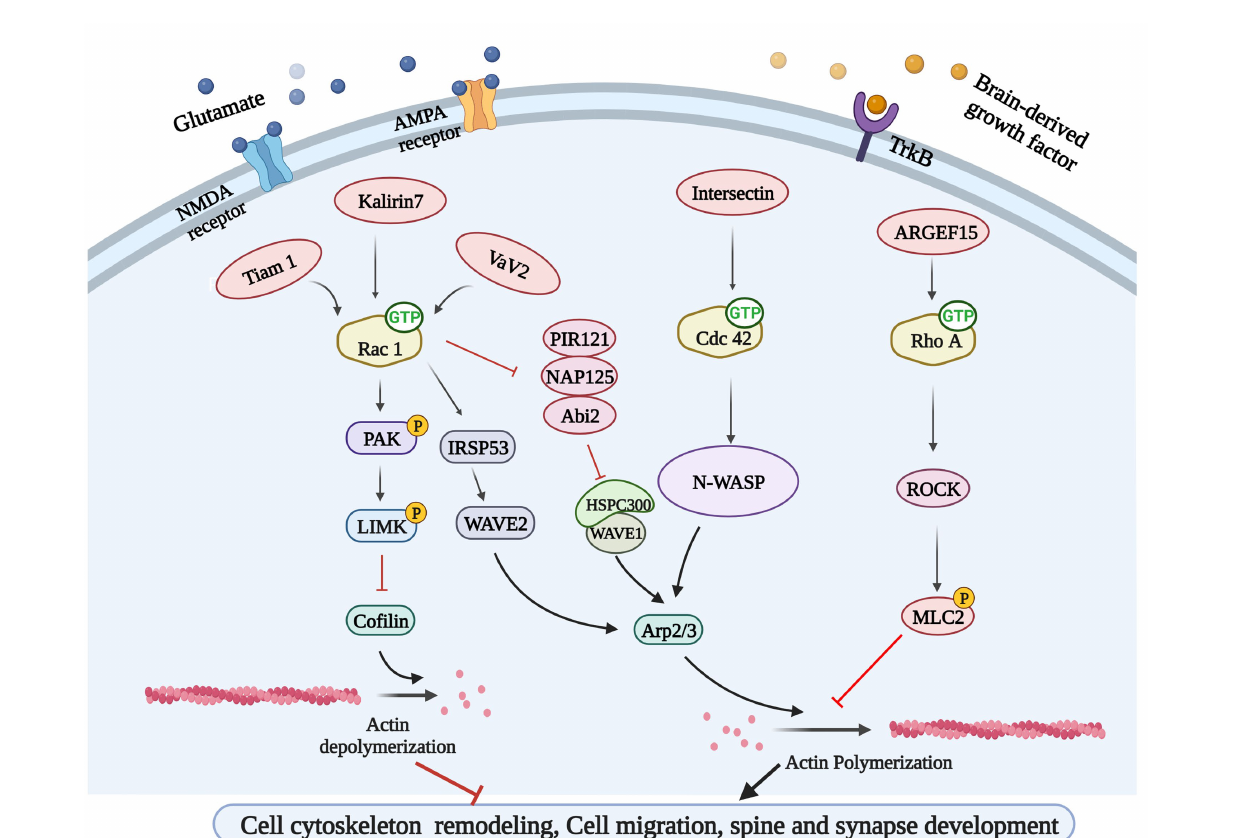
FIGURE 3 Rho GTPases-related signaling pathways. Glutamate and brain-derived neurotrophic factor (BDNF) could bind to their corresponding receptors and activate Rho GEFs, leading to Rho GTPases activation. Rho GEFs including Tiam 1, Kakirin 7, and Vav2 could activate Rac 1 and participate in cytoskeleton remodeling and synapse development through PAK/LIMK/Cofilin pathway and IRSP53/WAVE2 pathway. Rho GEF Intersection can activate N-WASP to regulate cytoskeleton remodeling by activating another GTPases Cdc42. ARGEF15 is also involved in this process by activating Rho A and its downstream